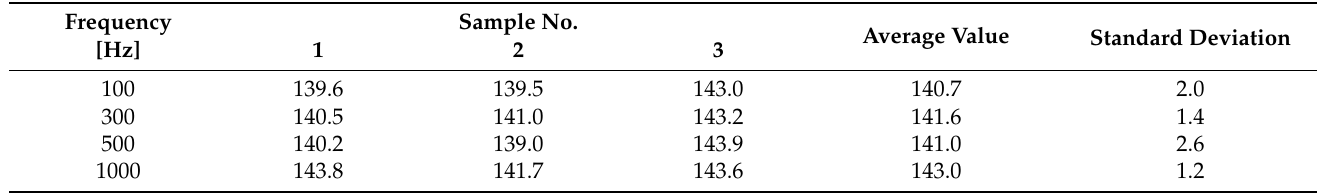
Table 4. Dynamic stiffness (dB re. 1 N/m) for PSMA8 poroelastic pavement with PA11 as binder course—measurements in situ (S).